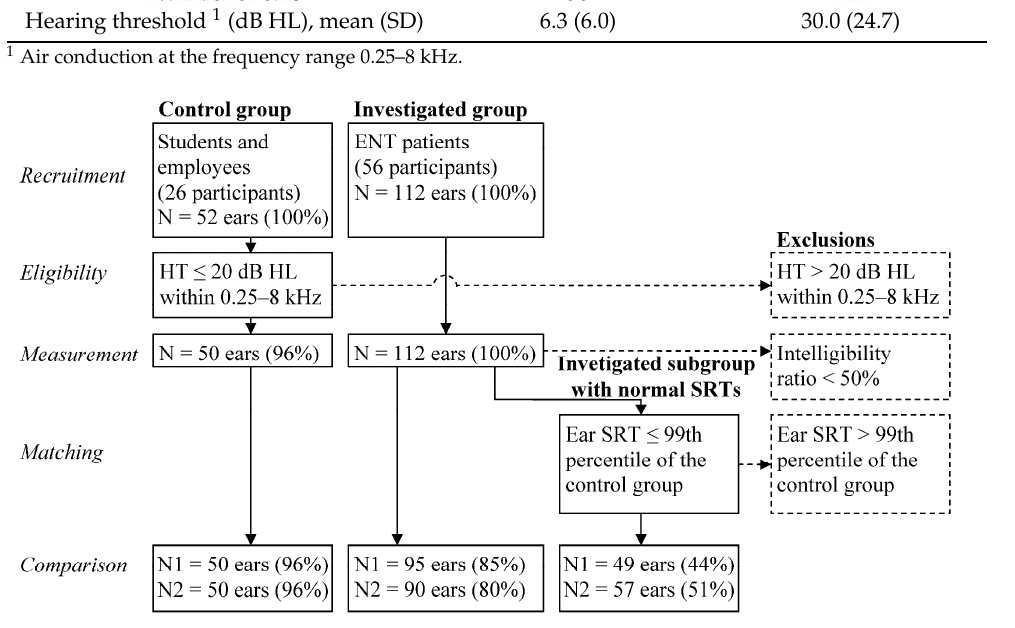
Figure 1. Attrition diagram (HT—air conduction hearing threshold, SRT—speech reception threshold, N1, N2—number of ears for continuous and modulated noise, respectively).